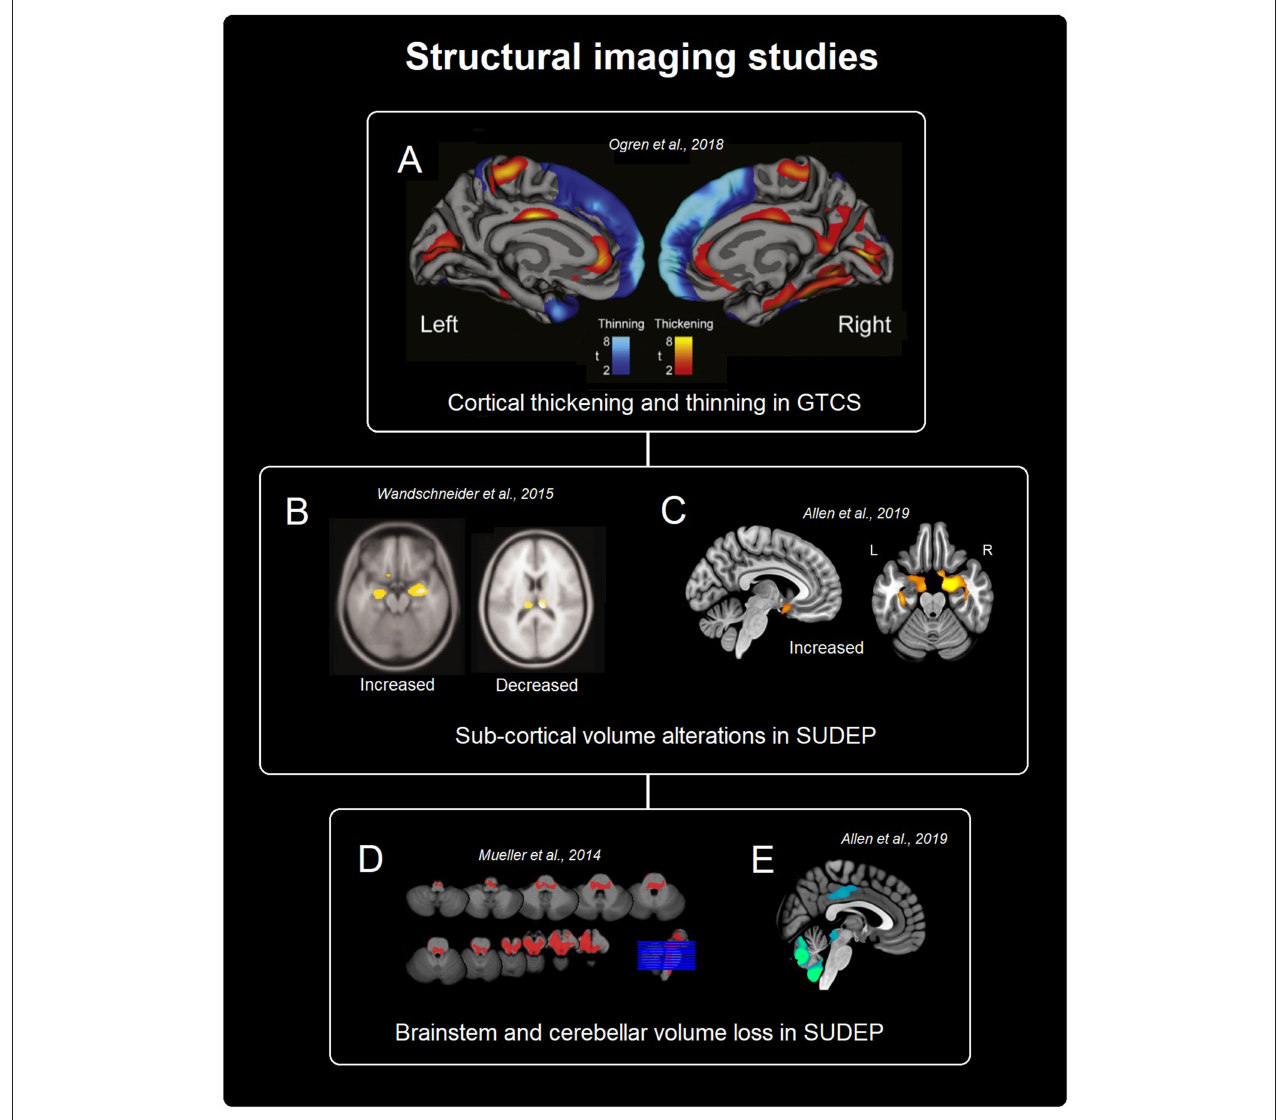
FIGURE 1 | Summary of structural findings from imaging studies in SUDEP and populations at high-risk of SUDEP. (A) Shows cortical thickness changes in patients with GTCS (32). (B,C) Show sub-cortical gray matter alterations in SUDEP [(20), B and (21), C ]. (D,E) Depict brainstem and cerebellar volume loss related to SUDEP [(33), D and (21), E